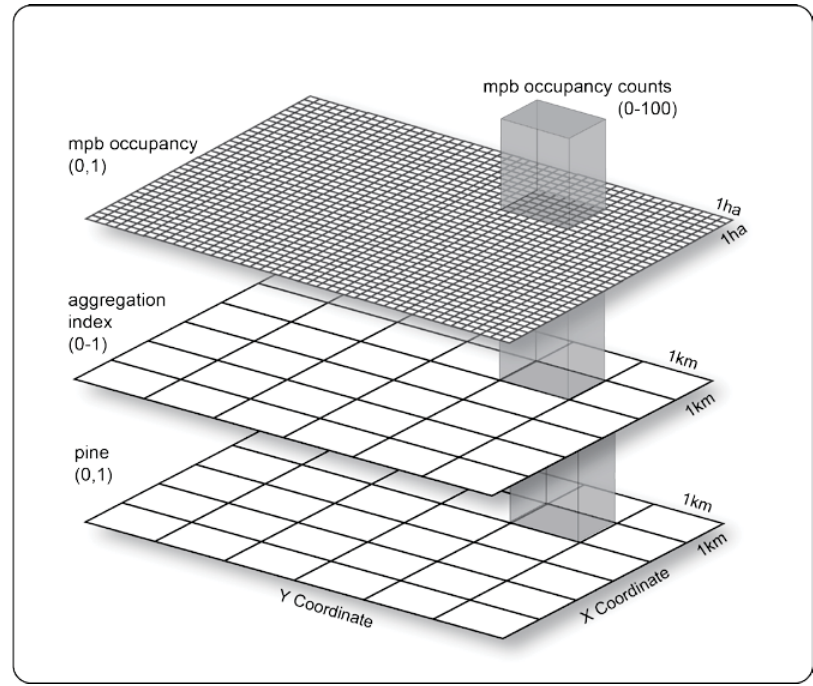
Figure 5. Data integration for developing the regression model. For each 1 km cell in which pine is present, the significance of the Aggregation Index for predicting counts of mountain pine beetle occupancy was